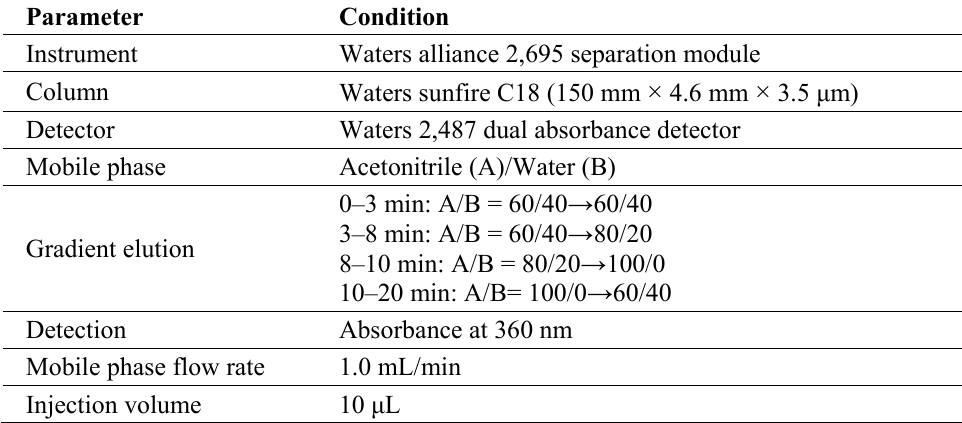
Table 4. Conditions for formaldehyde analysis using the